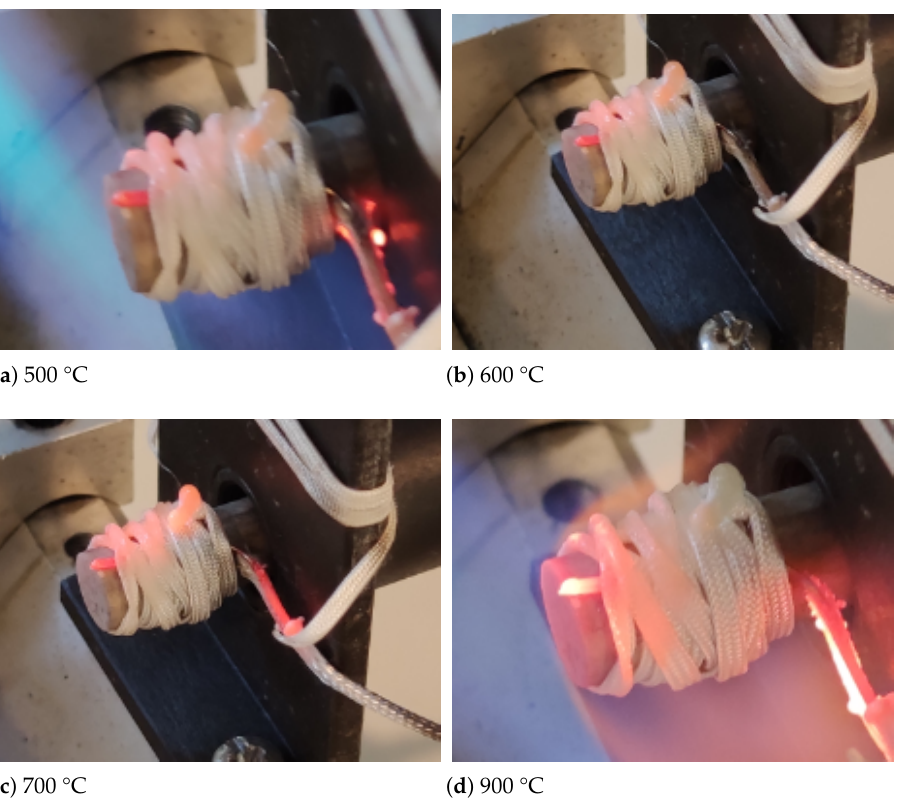
Figure 8. Probe at gradually increased